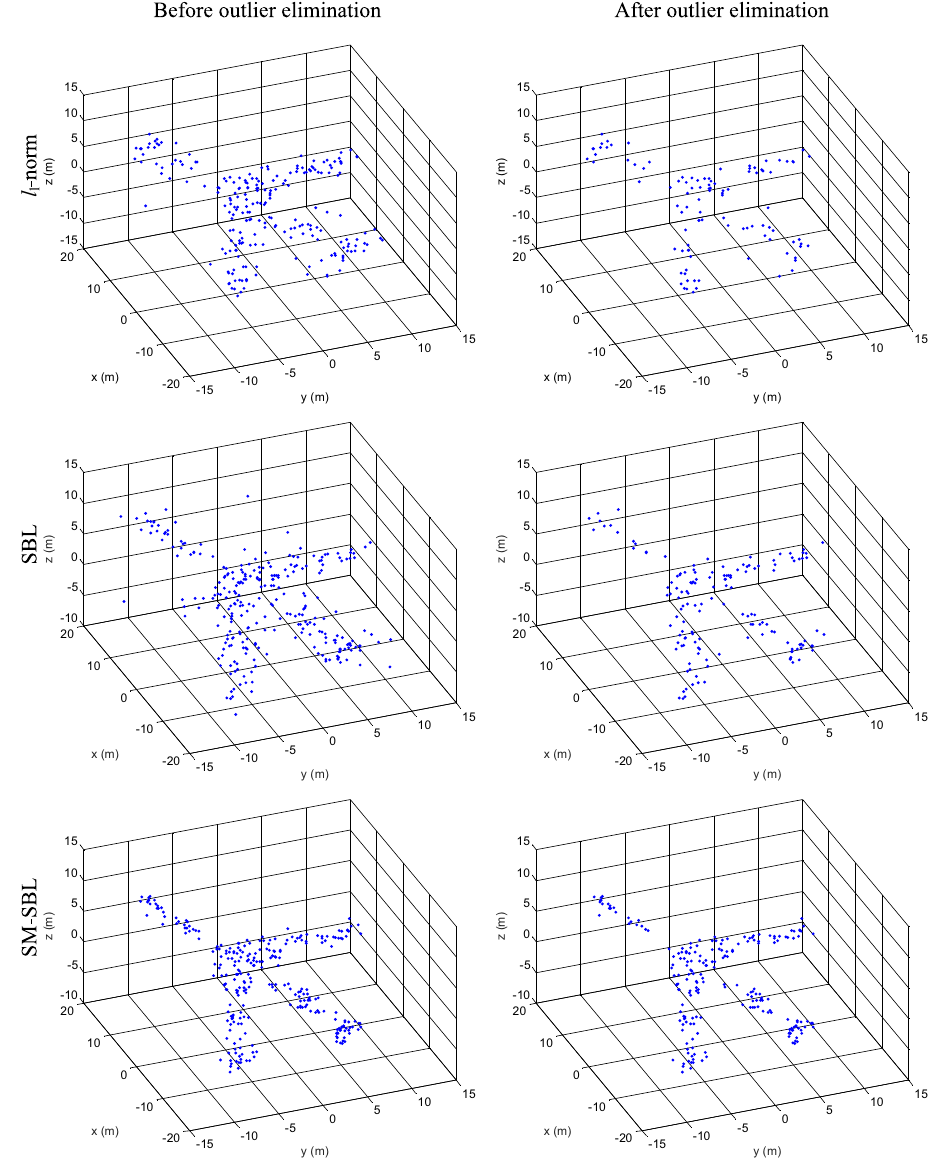
Figure 10. Reconstructed 3-dimensional (3-D) scatterer distribution for gap missing sampling (RMS).